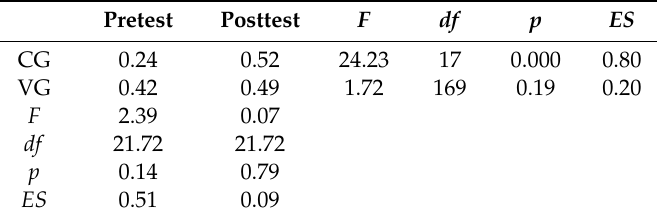
Table 3. Total gaze duration (seconds) per shot (mean values), F -values, degrees of freedom (df ), p -values, and size e ff ects ( ES ) for pairwise comparisons of CG and VG in pre- and posttests. Pretest Posttest